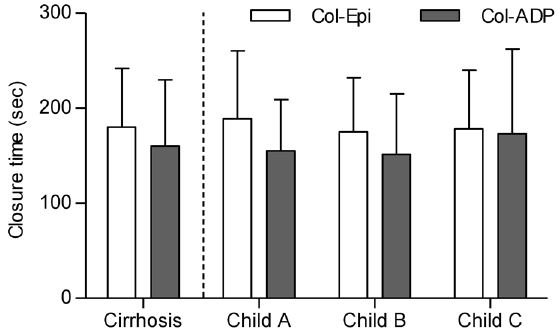
Figure 2. Results for PFA-100 in cirrhotic patients. Overall, mean closure times were above the upper limit of normal for Col-Epi ( . 165 s) and Col-ADP ( . 118 s) in cirrhotic patients. There were no significant differences between patients with different Child-Turcotte-Pugh scores.